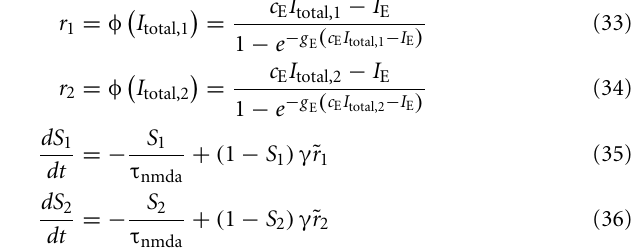
I as a function of the level